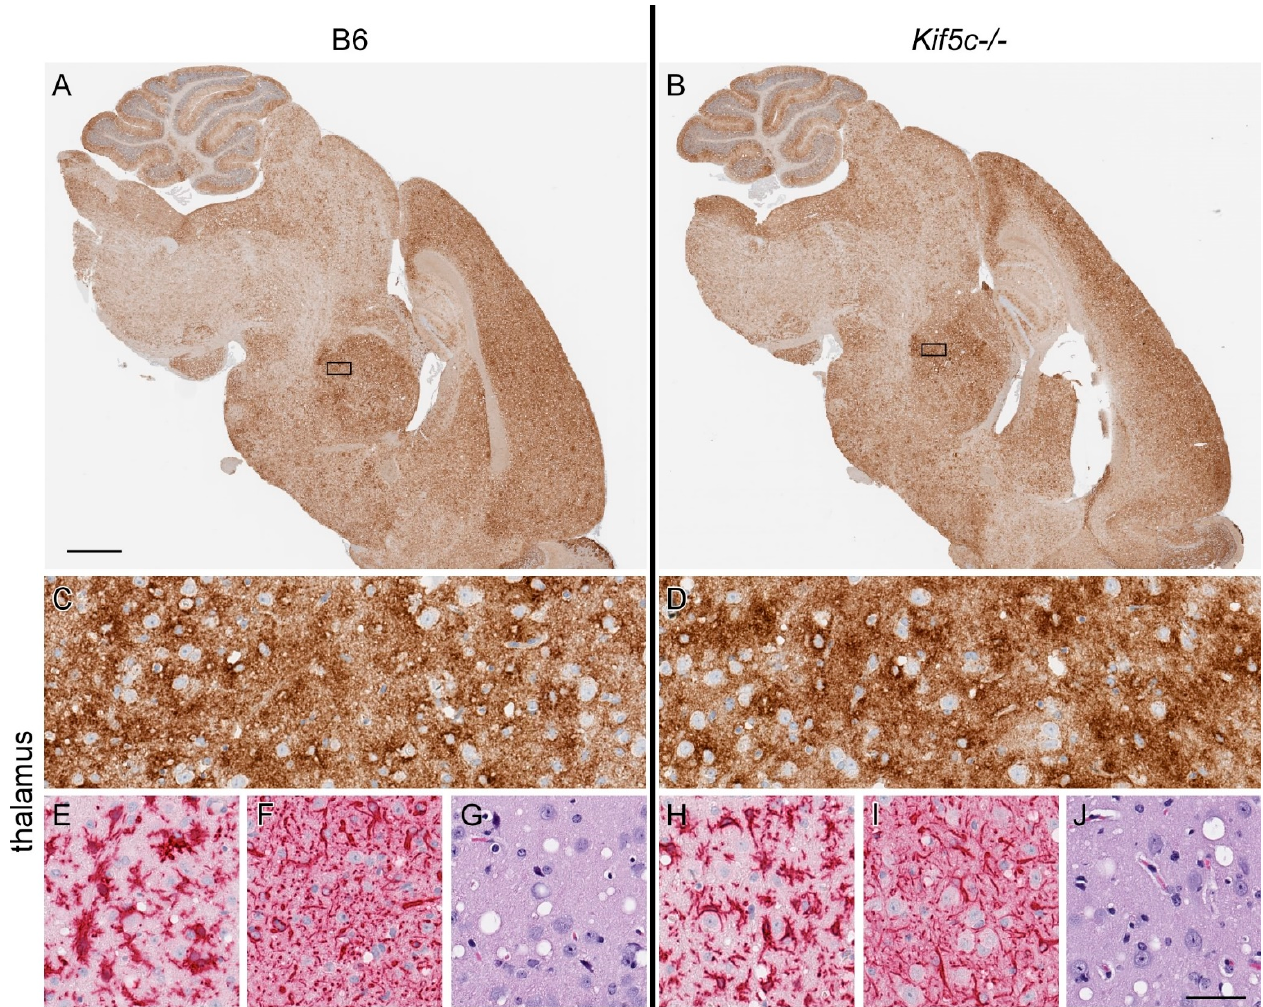
Figure 7. PrPSc deposition and neuropathology in brain collected from terminally sick 22 L-infected B6 and Kif5c − / − mice at 129 dpi. A representative B6 mouse is shown on the left side, and a Kif5c − / − mouse on the right. ( A , B ) IHC using anti-PrP antibody D13 (brown) performed on sagittal brain sections. PrPSc is widely distributed in both strains of mice. The black rectangle indicates the approximate area of thalamus shown at higher magnification in panels C–J. ( C , D ) High magnification D13 IHC. ( E , H ) Anti-Iba1 IHC showing activated microglia in thalamus. ( F , I ) Anti-GFAP IHC showing astrocytosis. ( G , J ) Hematoxylin and eosin (H&E) staining demonstrating spongiform lesions. No differences were observed in the distribution or amount of PrPSc, gliosis or spongiform degeneration between the two mouse strains. The scale bar in A is 1 mm and applies to panels A and B. The scale bar in J is 50 µm and applies to panels C–J.